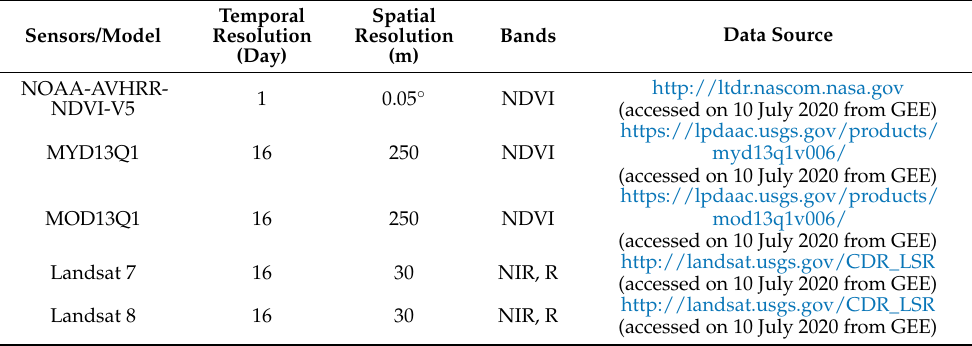
Table 2. Remote sensing data and their specifications used for this